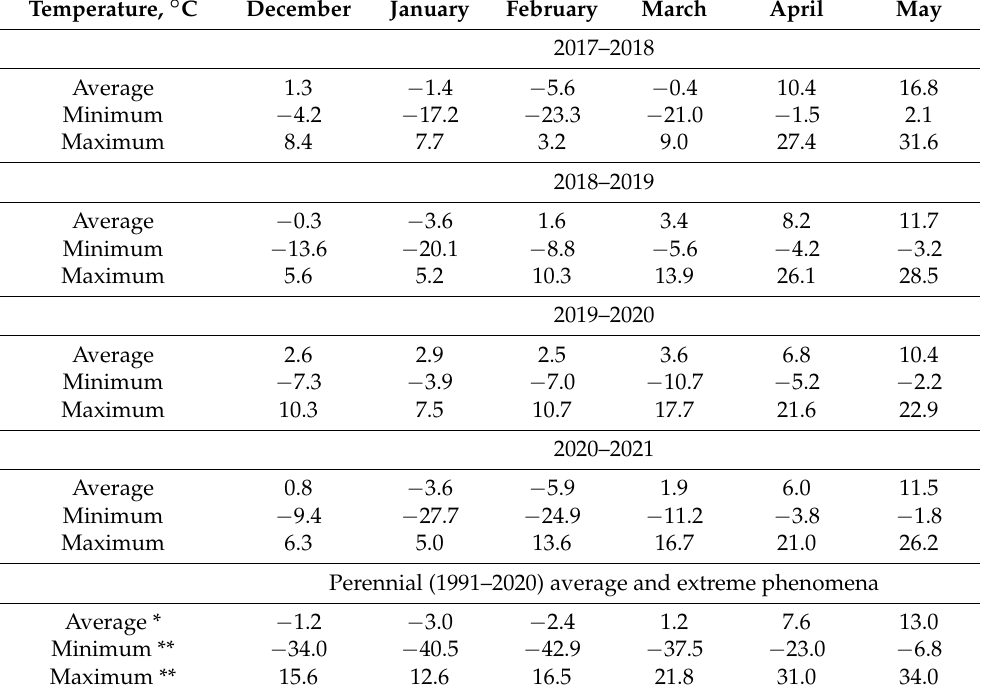
Table 9. Air temperature in the winter–spring period. Records of the iMETOS ® (Pessl Instru- ments GmbH, Weiz, Austria) meteorological station in Babtai and Lithuanian Hydrometeorological Service [54] (* Galerija—Meteo.lt; ** Extreme